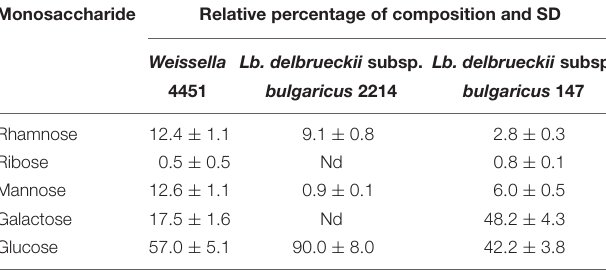
TABLE 1 | Monosaccharides composition of EPS, reported as relative